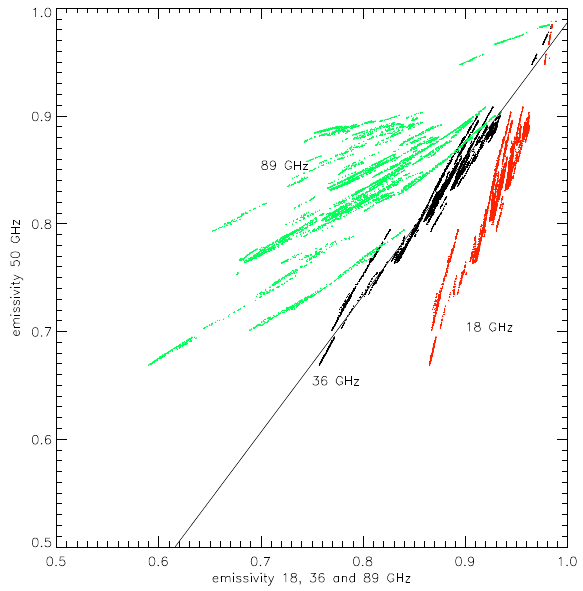
Fig. 3. The simulated 18, 36 and 89GHz emissivity at vertical polar- Figure 3. The simulated 18, 36 and 89 GHz emissivity at vertical polarisation of multiyear ice vs. the isation of multi-year ice vs. the 50GHz emissivity. The 18GHz vs. 50 GHz emissivity. The 18 GHz vs. the 50 GHz emissivity is shown in red, the 36 GHz vs. the 50GHz the 50GHz emissivity is shown in red, the 36GHz vs. the 50GHz in black, and the 89 GHz vs. the 50GHz in green. The line is fitted to the 36 GHz vs. 50 GHz cluster: ev50=1.268ev36 - 0.28. in black, and the 89GHz vs. the 50GHz in green. The line is fitted to the 36GHz vs. 50GHz cluster: e v50 = 1.268 e v36 −